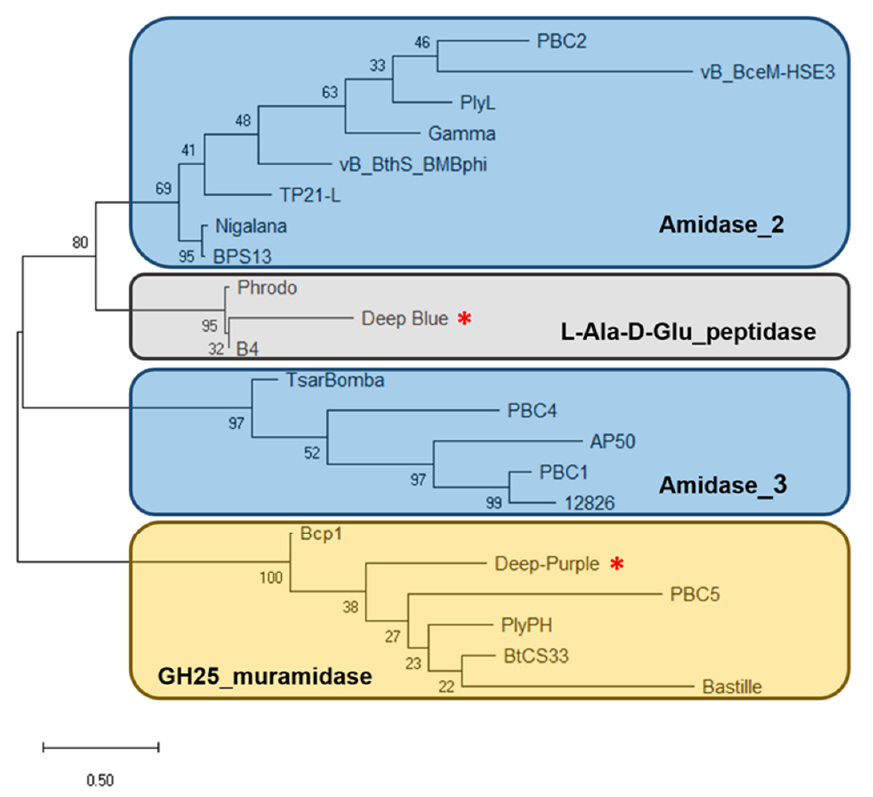
Figure 3. Dendrogram of relationships between the characterized endolysins of B. cereus phages. The tree was built using the maximum likelihood method and JTT matrix-based model with 100 bootstrap iterations. Endolysins are indicated by the name of the phage they derived from. Endolysins with the same EAD are grouped in the same cluster. Muramidases, amidases, and endopeptidases are highlighted as yellow, blue, and gray rectangles, respectively. Deep-Blue and Deep-Purple endolysins are indicated by red asterisks. The bar indicates 0.5 substitutions per amino acid site. The numbers refer to the percentage of trees in which the associated endolysins clustered together.